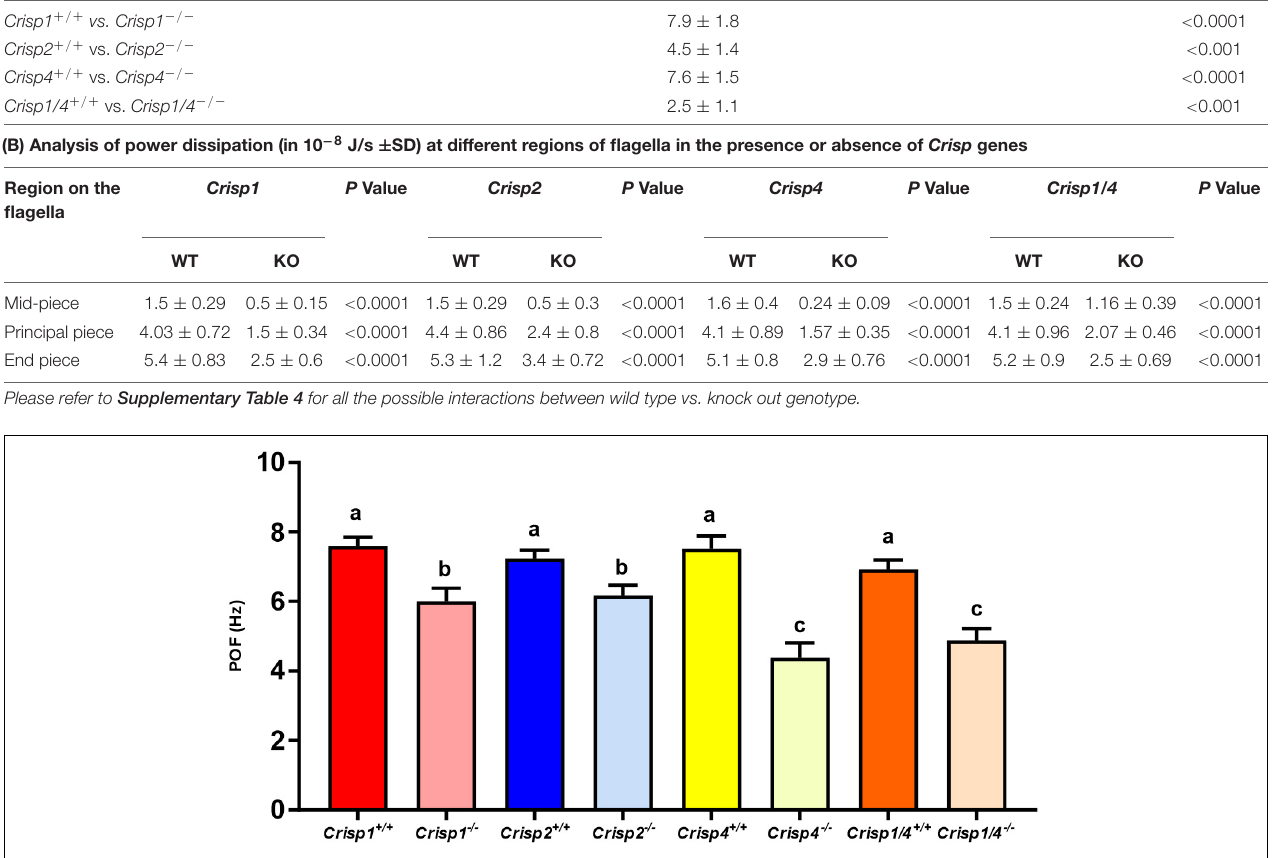
Frontiers in Cell and Developmental Biology |